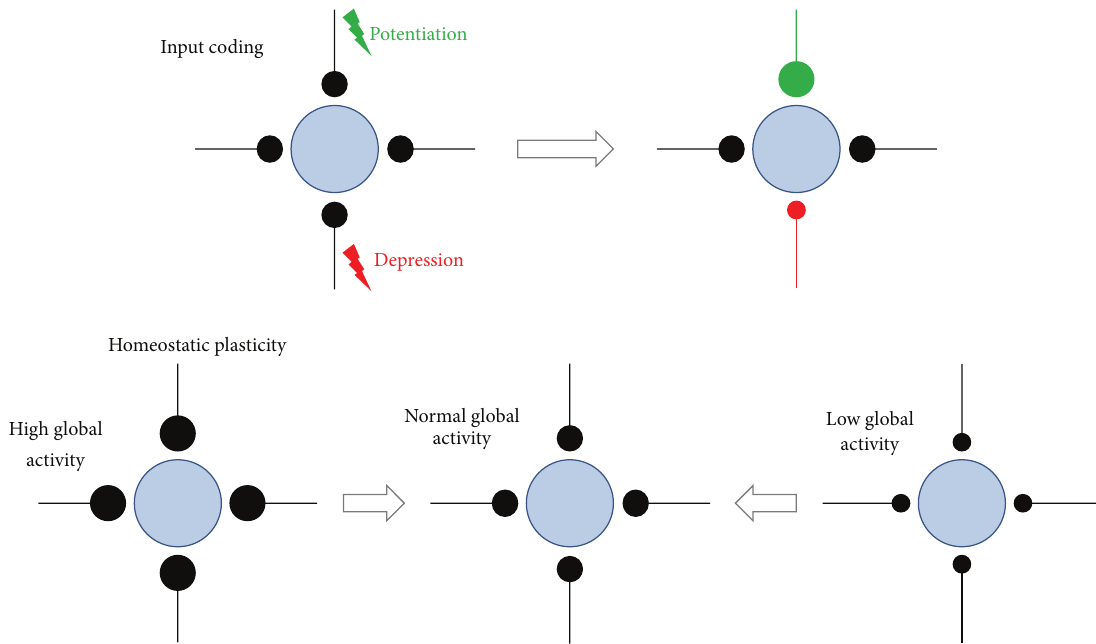
Figure2:Aschematicofcodingandhomeostaticplasticity.Incodingplasticity,aspecificpatternofactivityonaparticularinputtotheneuron leads to the strengthening or weakening of that connection. A common form of homeostatic plasticity known under the name of synaptic scaling involves proportional changes to all of the synapses to a neuron in order to keep its mean activity within a specified operating range. Blue circles represent postsynaptic cells and black lines/circles synaptic inputs. Wider synaptic inputs represent greater synaptic